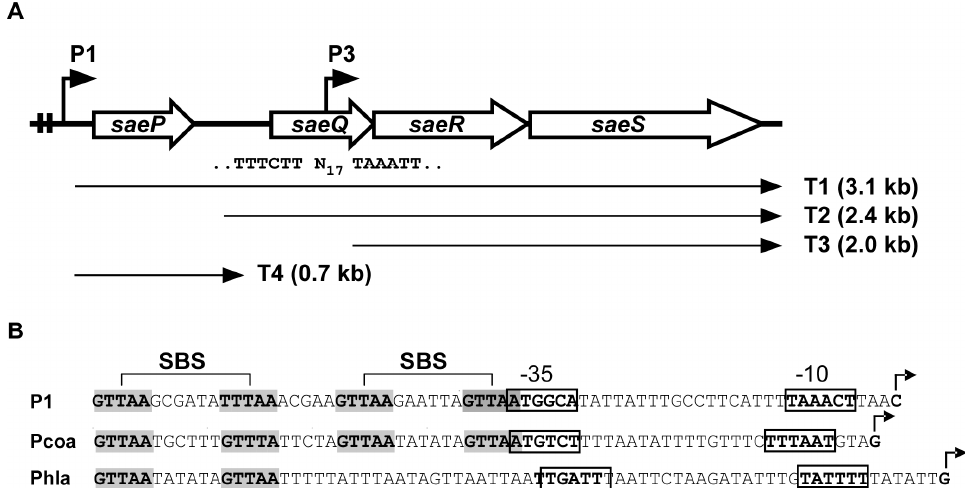
Figure 1. The sae operon. ( A ) Organization of the sae operon. Two angled arrows represent the P1 and P3 promoters, respectively. Two vertical lines in the P1 promoter region indicate the SaeR binding sequences (SBSs). The nucleotide sequence of the P3 promoter is shown under saeQ, where N 17 = 17 nucleotides. Four transcripts (T1–T4) are indicated by arrows; ( B ) DNA sequences of select sae target promoters. The SBSs are shown in gray. Transcription start sites are indicated by angled arrows. The promoter sequences are shown in boxes. Pcoa, the promoter of coagulase ( coa ); Phla, the promoter of α‐ hemolysin ( hla ).